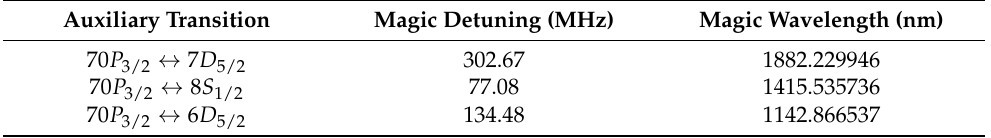
Table 1. At magic angle, magic detunings and magic wavelengths of the 6 S 1/2 ↔ 70 P 3/2